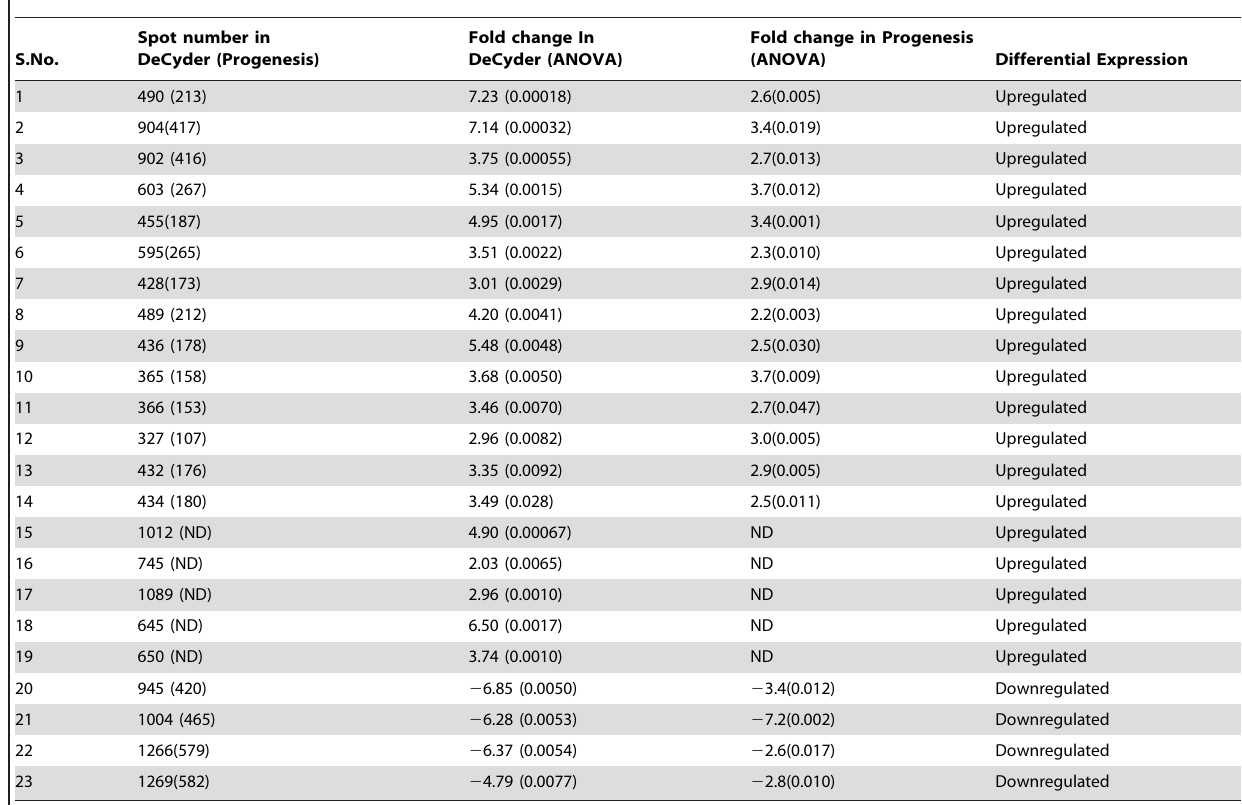
Table 1. Selected protein spots from comparative analysis of differentially expressed proteins in DeCyder and Progenesis software.